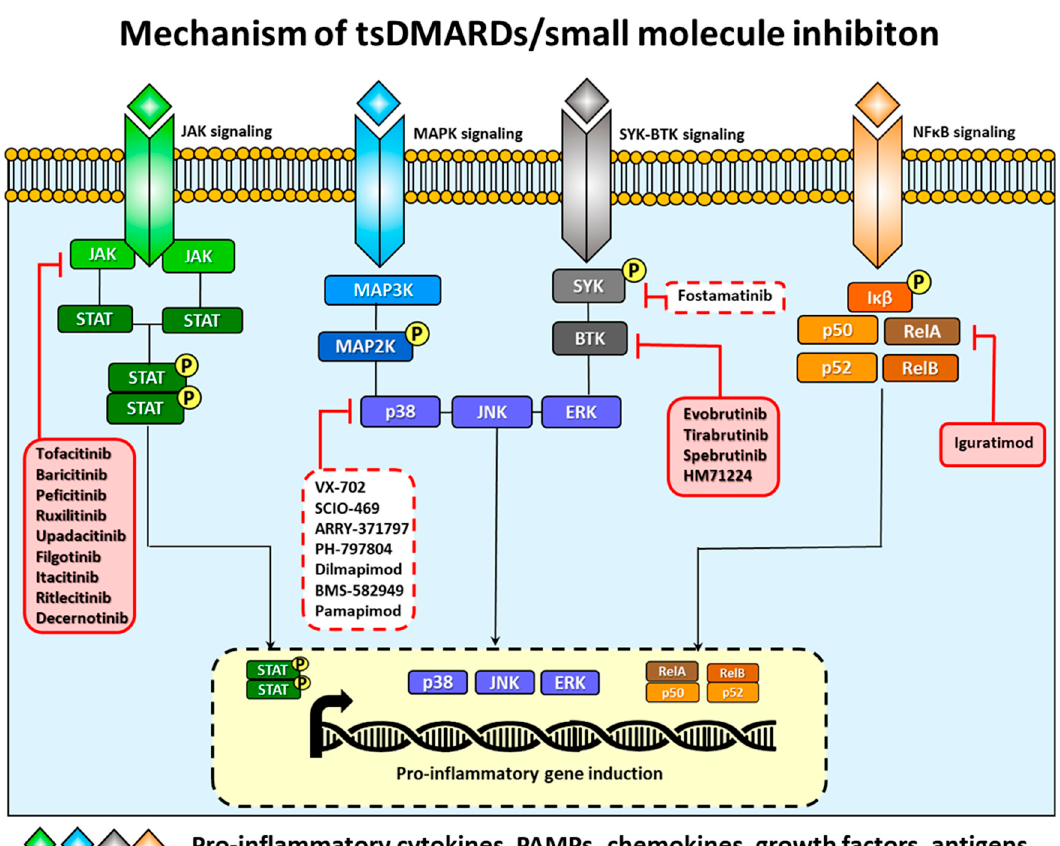
Figure 1. The mechanism of target synthetic DMARDs (tsDMARDs) inhibition in rheumatoid arthritis (RA). tsDMARDs, also known as small molecule inhibitors, are involved in blocking several pro-inflammatory pathways including JAK / MAPK / SYK-BTK / NF- κ B signaling. tsDMARDs which are currently investigated in clinical trials or already approved for RA treatment are highlighted by the red rectangles, tsDMARDs which are terminated are highlighted by the white rectangles with dashed line.